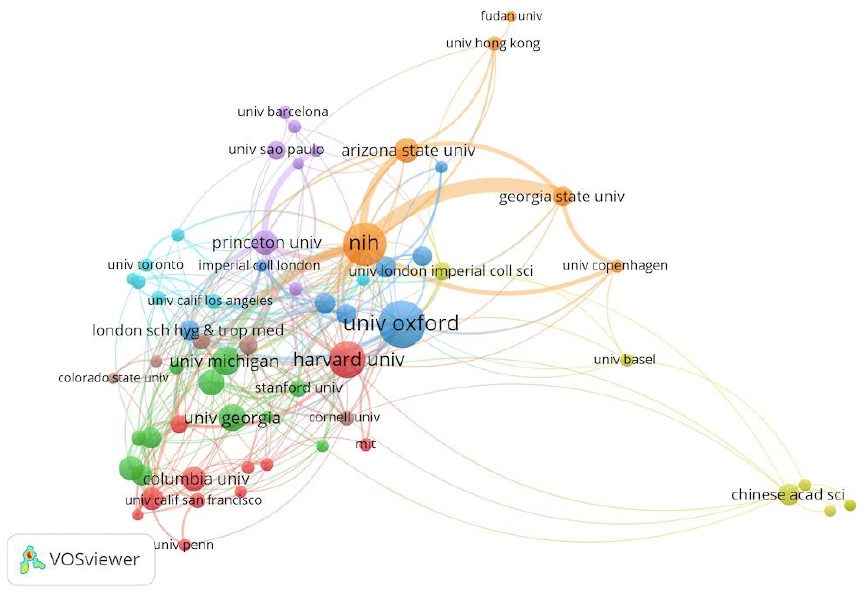
Figure 6. Collaborative network of institutions in the field of the prediction of infectious diseases. Table 3. The top 10 collaborative institutions in the field of the prediction of infectious diseases. Rank